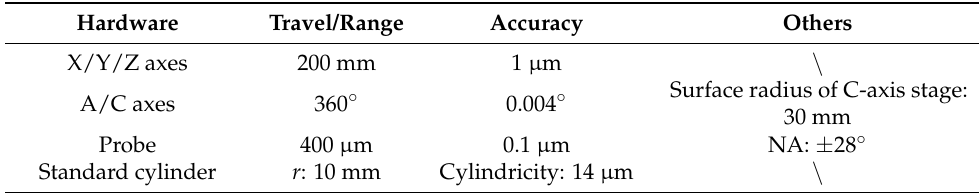
Figure 10. The experimental setup: 1—X axis; 2—Y axis; 3—Z axis; 4—A axis; 5—C axis; 6—probe. Table 2. The parameters of the five-axis measurement system.